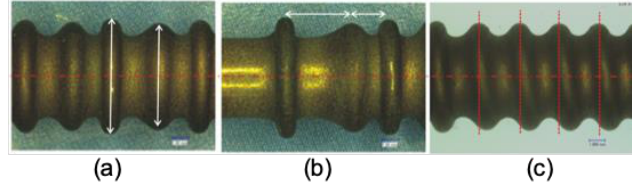
Figure 2. The problem of semi-dieless bellows forming on SUS 304 ( a ) Variety of bellows height, ( b ) Variety of bellows pitch, and ( c ) Asymmetric bellows shape.